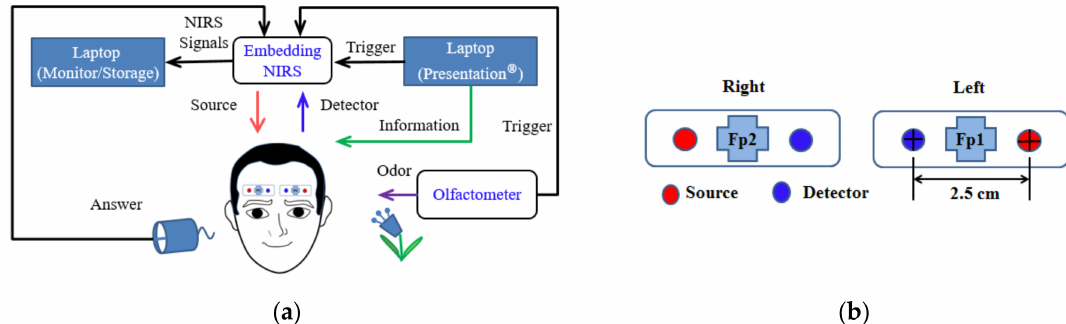
Figure 1. ( a ) Schematic of the study’s fNIRS system design. ( b ) Optode placement and channel location on the prefrontal cortex at reference points Fp1 and Fp2, in accordance with the International 10–20 System of placement. This system comprises two sources and two detectors, and each source–detector pair is separated by 2.5